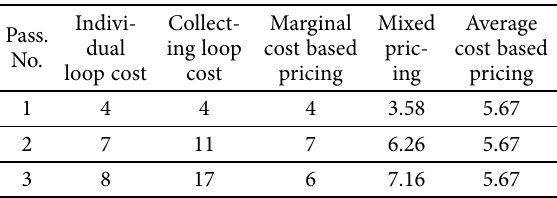
Table 3. Costs in the different pricing systems (the second step)